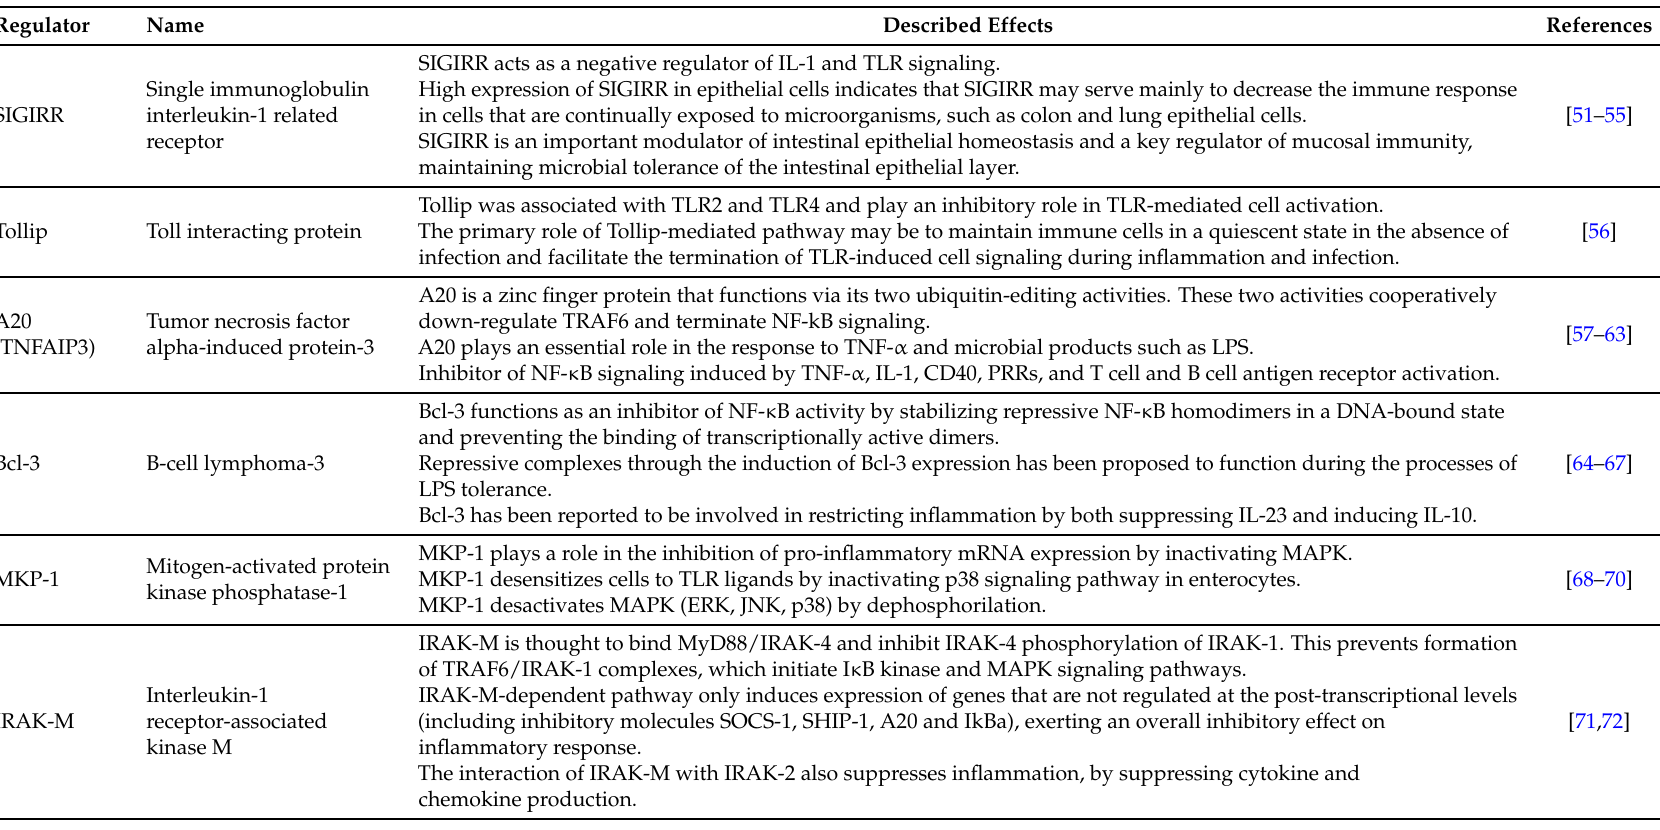
Table 2. Inhibitors of Toll-like receptor